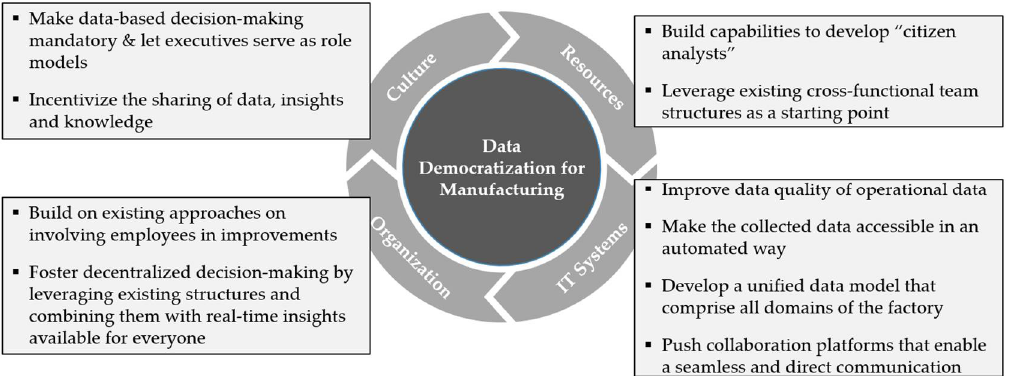
Figure 4. Essential fields of Data Democratization for Manufacturing .